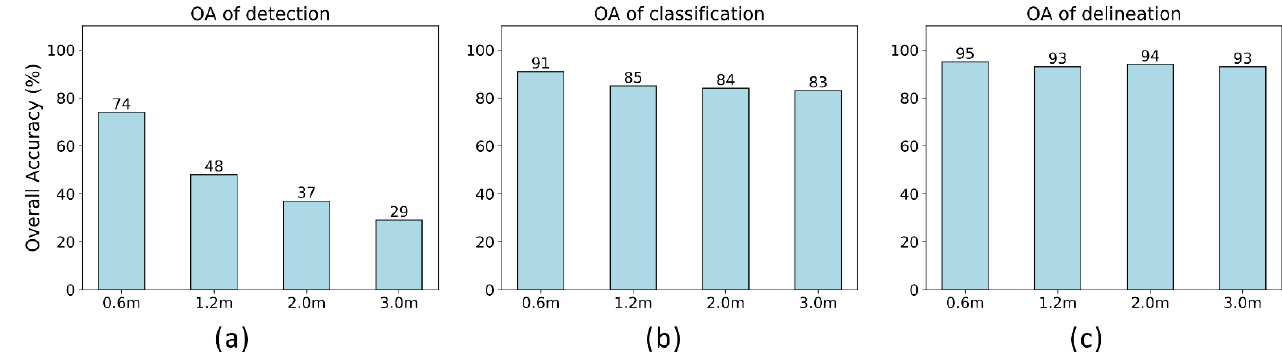
Figure 9. Statistical summary of overall accuracies of ( a ) detection, ( b ) classification and ( c ) delineation tasks on original and resampled images.